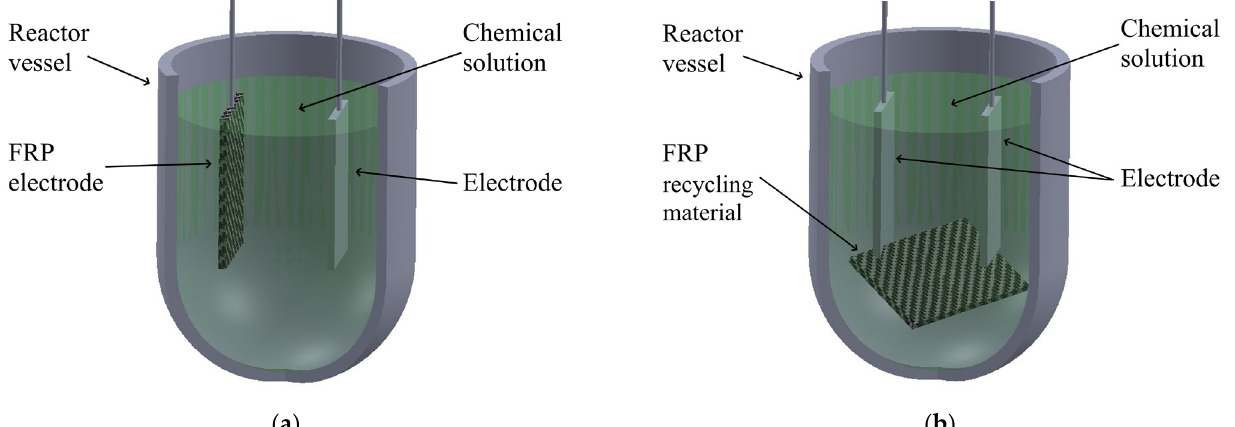
Figure 5. Schematisation of the electrochemical recycling process: FRP material used as electrode ( a ); FRP recycling material in electrochemical solution ( b ).